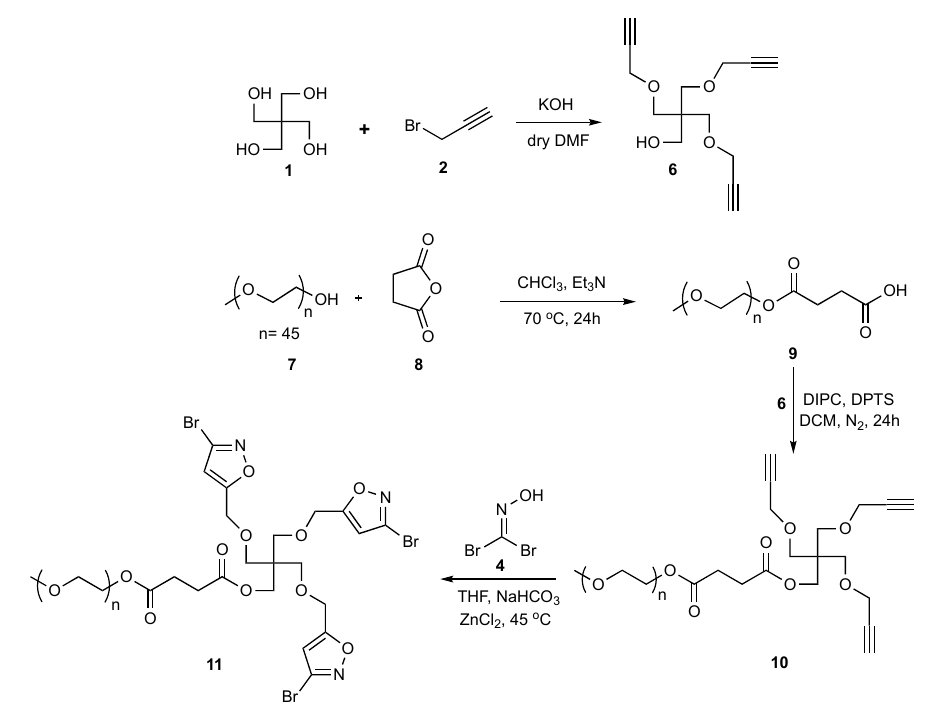
Scheme 2. Synthesis of isoxazole-mPEG architectural polymer ( 11 ).